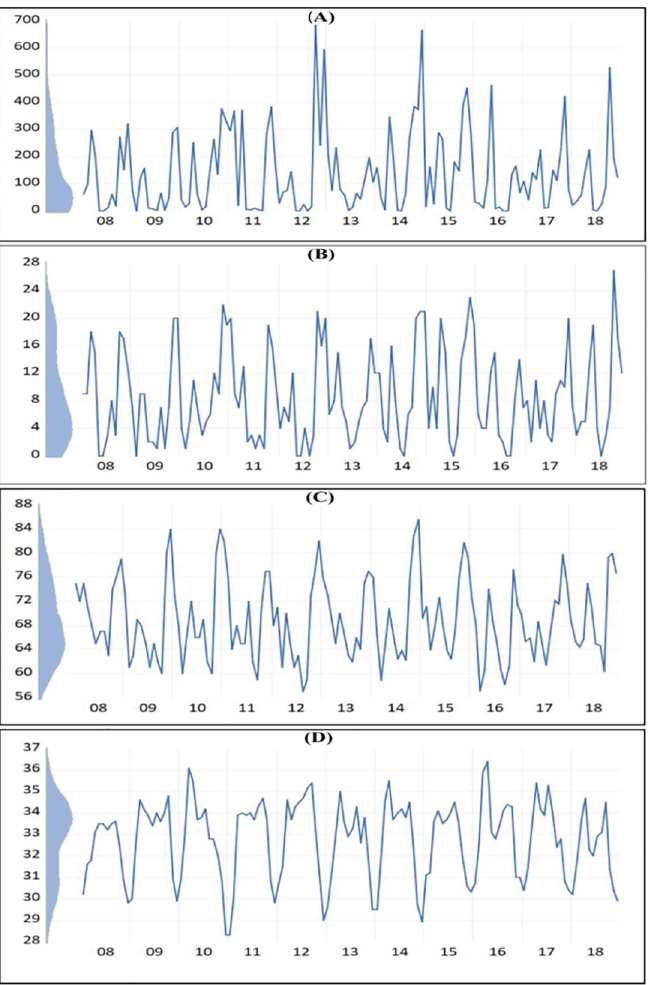
Fig 6. A-D: Distribution of monthly meteorological parameters from January 2008 to December 2018 in Anuradhapura District, Sri Lanka, with kernel density. (A-Rainfall; B-Rainy days; C-day time average relative humidity; D-maximum temperature).